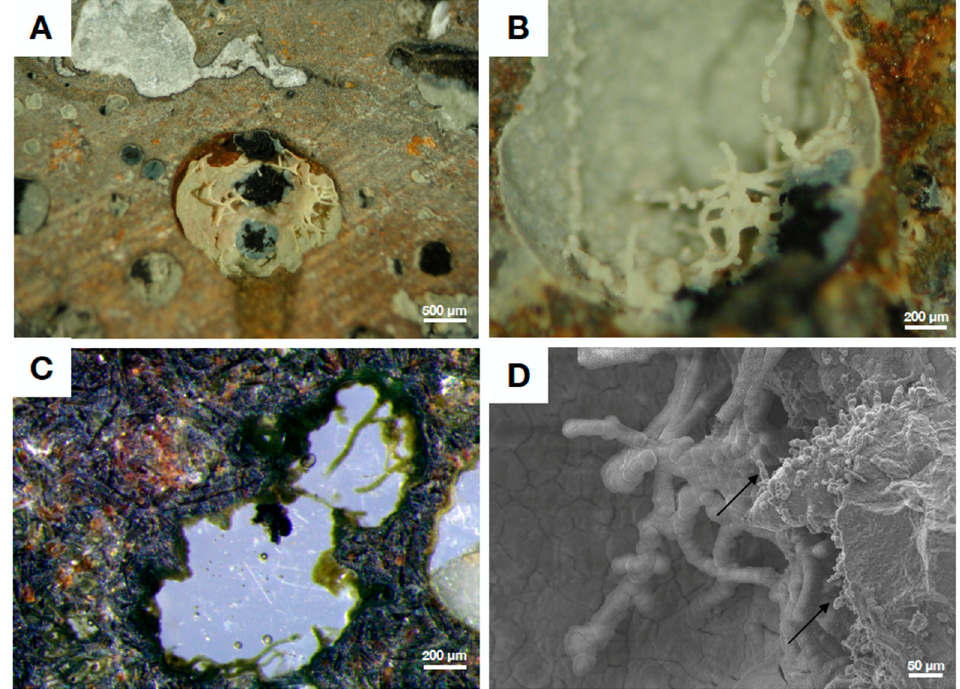
Figure 4. Stereo ( A – C ) and Scanning Electron micrographs of fungal biofilms protruding from the walls into empty or partly filled vescicles within basalt from Detroit seamount, samples 1204B-16R-01 and 1203A-57R3. ( A ) vesicle filled with authigenic clay (yellow-cream) and Mn-oxides (black). Fungal hyphae are preserved in clay within the vesicle. Scale bar equals 500 µ m. ( B ) Close-up of hyphae and basal biofilm preserved as clay with a basalt matrix. Scale bar equals 200 µ m. ( C ) Vesicle with green-colored clay mineralized filaments and biofilm protruding into an empty void surrounded by basalt matrix. Scale bar equals 200 µ m. ( D ) Fungal mycelia with potential sporophore structures (arrows). Scale bar equals 50 µ m.